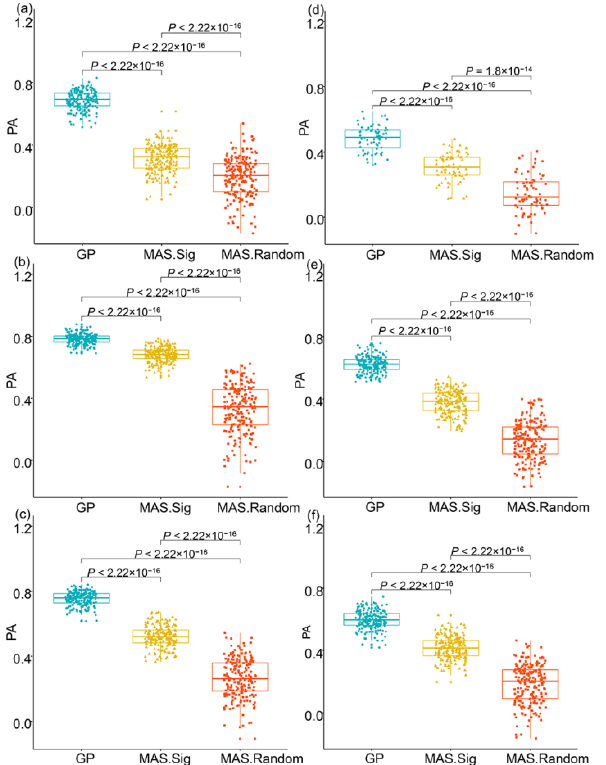
Figure 4. Using the significant SNPs to predict phenotypes in each population. ( a – c ) PAs of the GP, MAS.Sig and MAS.Random model in predicting HKW in the LPS ( a ), Chang7-2 TC ( b ) and PH6WC TC ( c ) populations, ( d – f ) PAs of the GP, MAS.Sig and MAS.Random models in predicting YPP in the LPS ( d ), Chang7-2 TC ( e ) and PH6WC TC ( f ) populations. GP indicates GP models using all SNPs; MAS.Sig indicates MAS models using the significant SNPs; MAS.Random indicates MAS models using the same number of randomly selected SNPs. P values indicate significant levels of Wilcox.test.